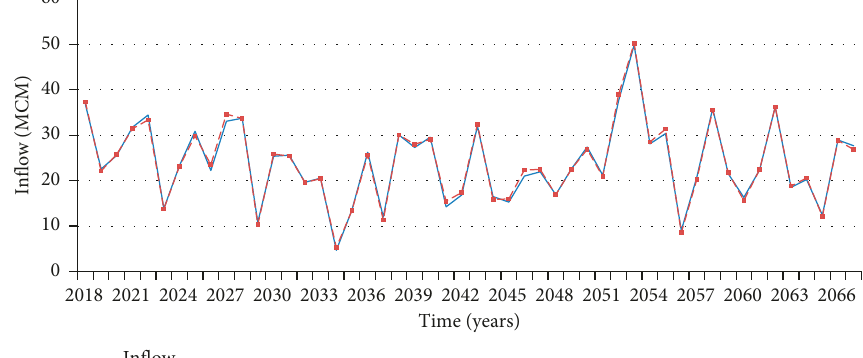
Figure 20: Future runoff into Huay Sabag reservoir.